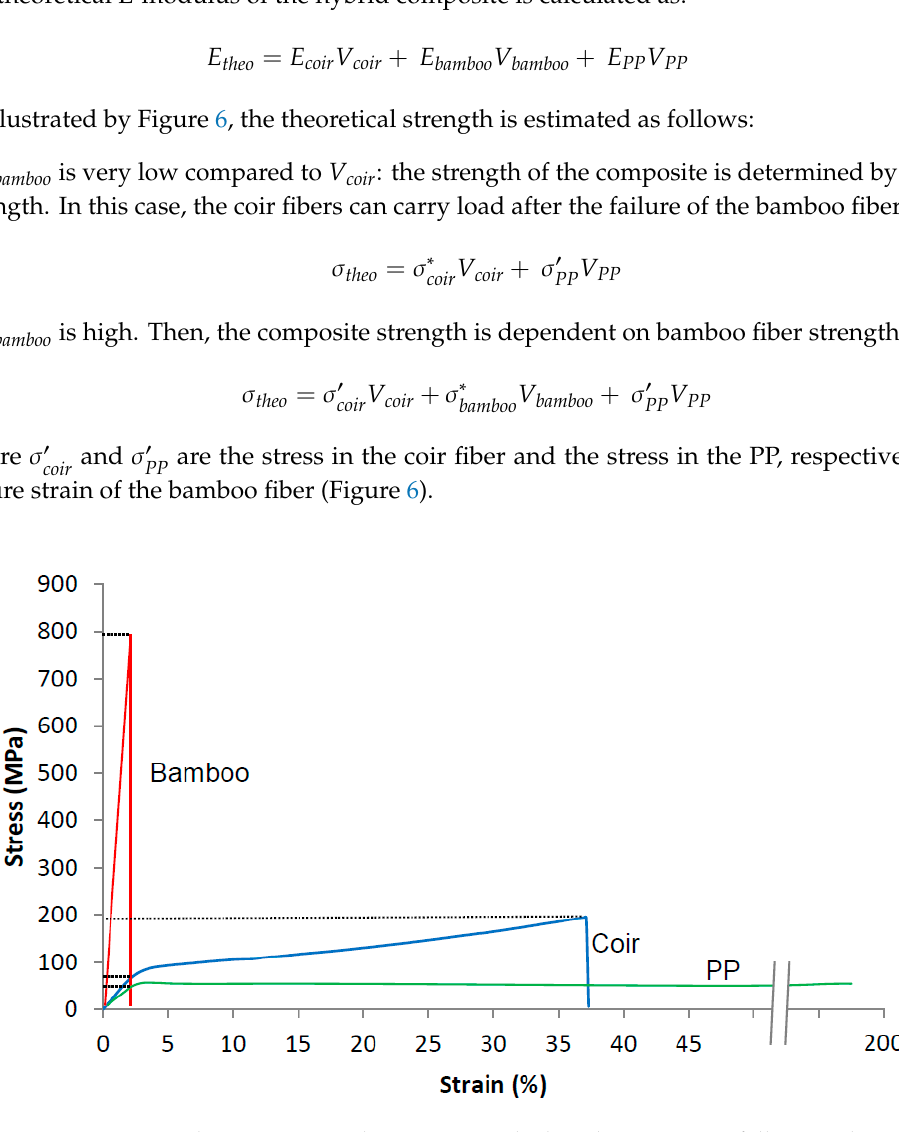
Figure 6. Mono-material properties used as input to calculate the properties following the rule of mixtures of the coir-bamboo/PP hybrid composite.